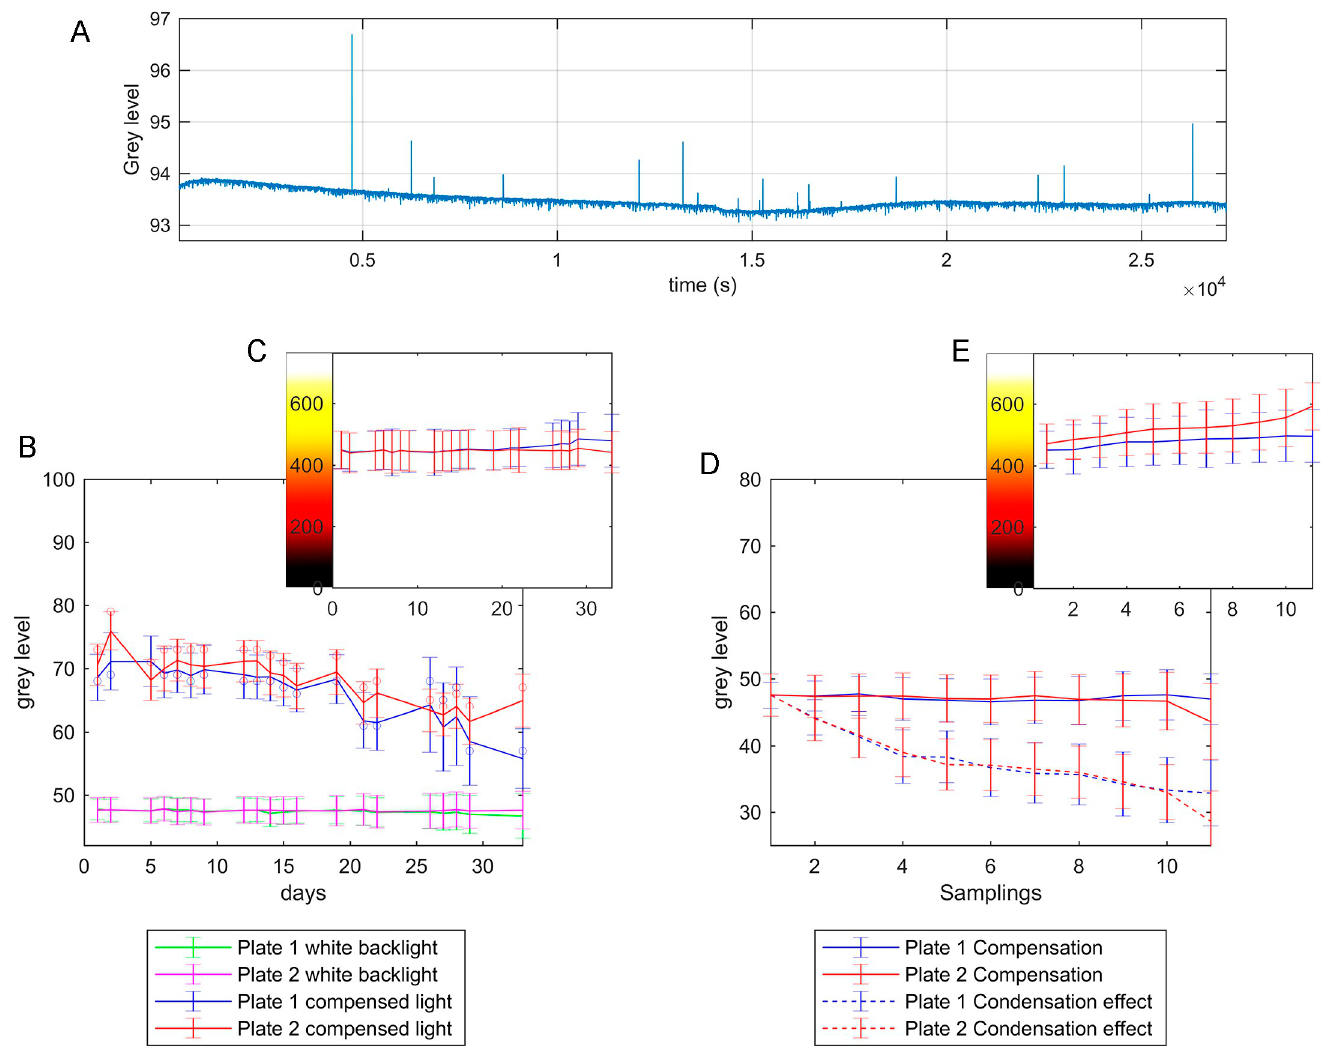
Fig 8. Temporal variability graphics. A: The average grey level of the image produced by a white backlight with time (about 30,000s). B: The mean grey levels and deviations of two plates for the white backlight and for the compensated light. C: The mean control signals and deviations applied for compensating images: (B) every day. D: The mean grey levels and deviations of two plates with condensation slowly increasing for the new backlight compensation every time that the mean image grey level error dropped below -3, and for the compensated light at the beginning (this lasted approximately 2h). E: The mean control signals and deviations applied for compensating the images in (D) during each new compensation